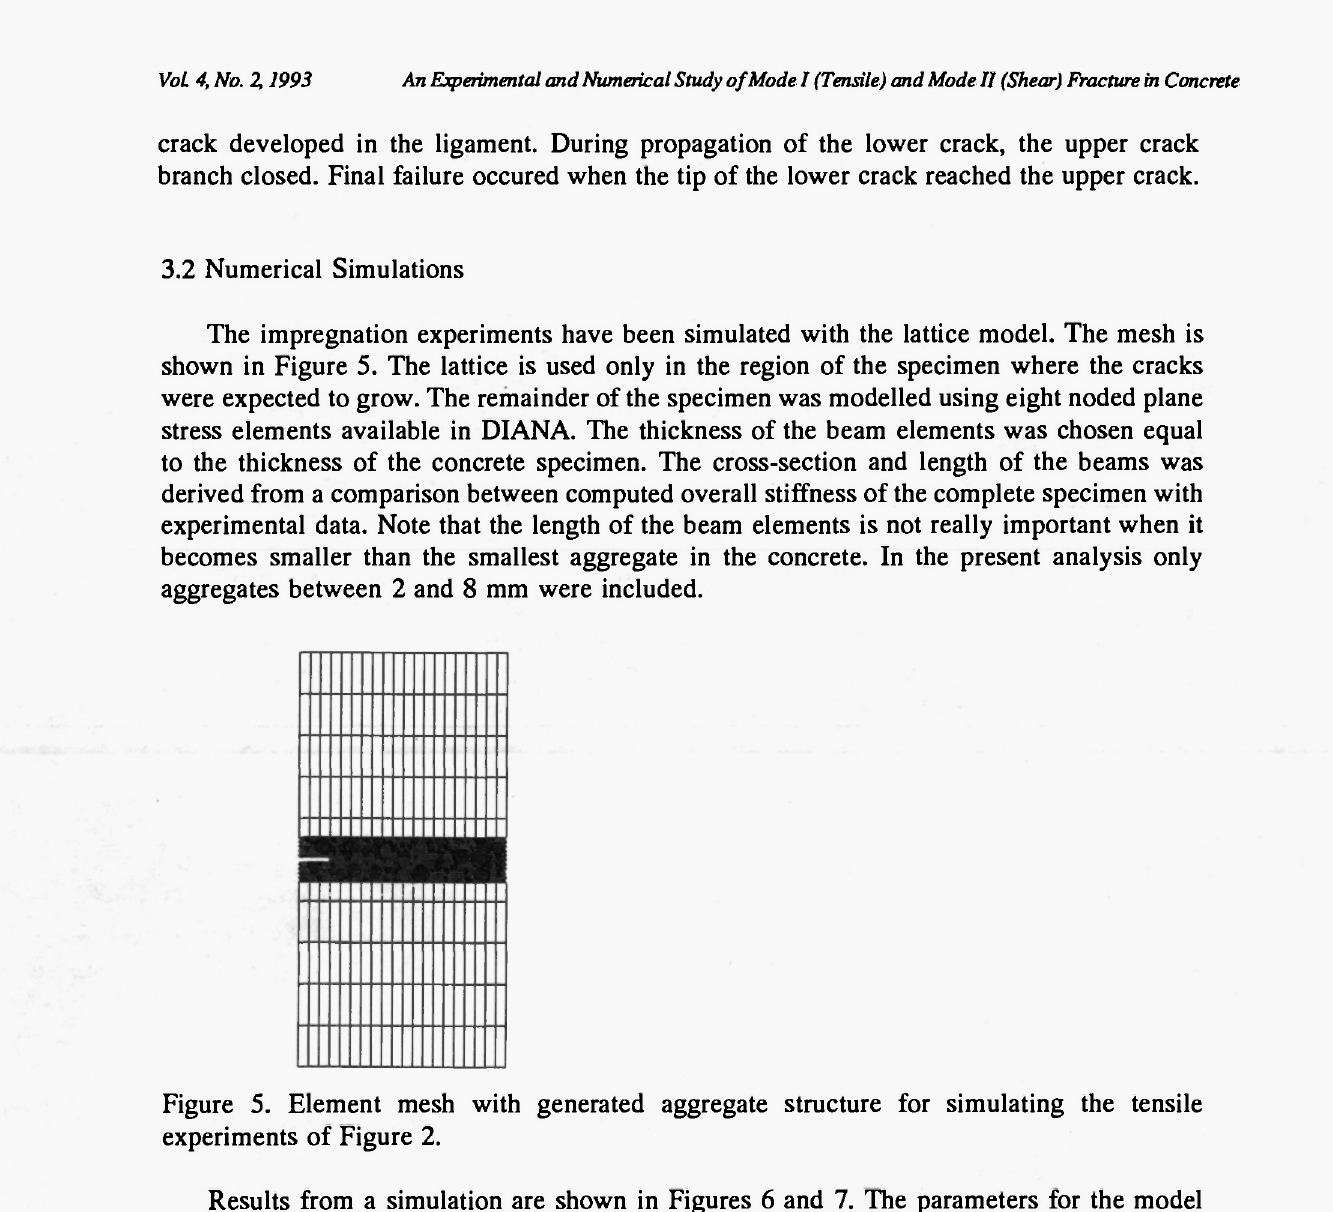
Figure 5. Element mesh with generated aggregate structure for simulating the tensile experiments of Figure